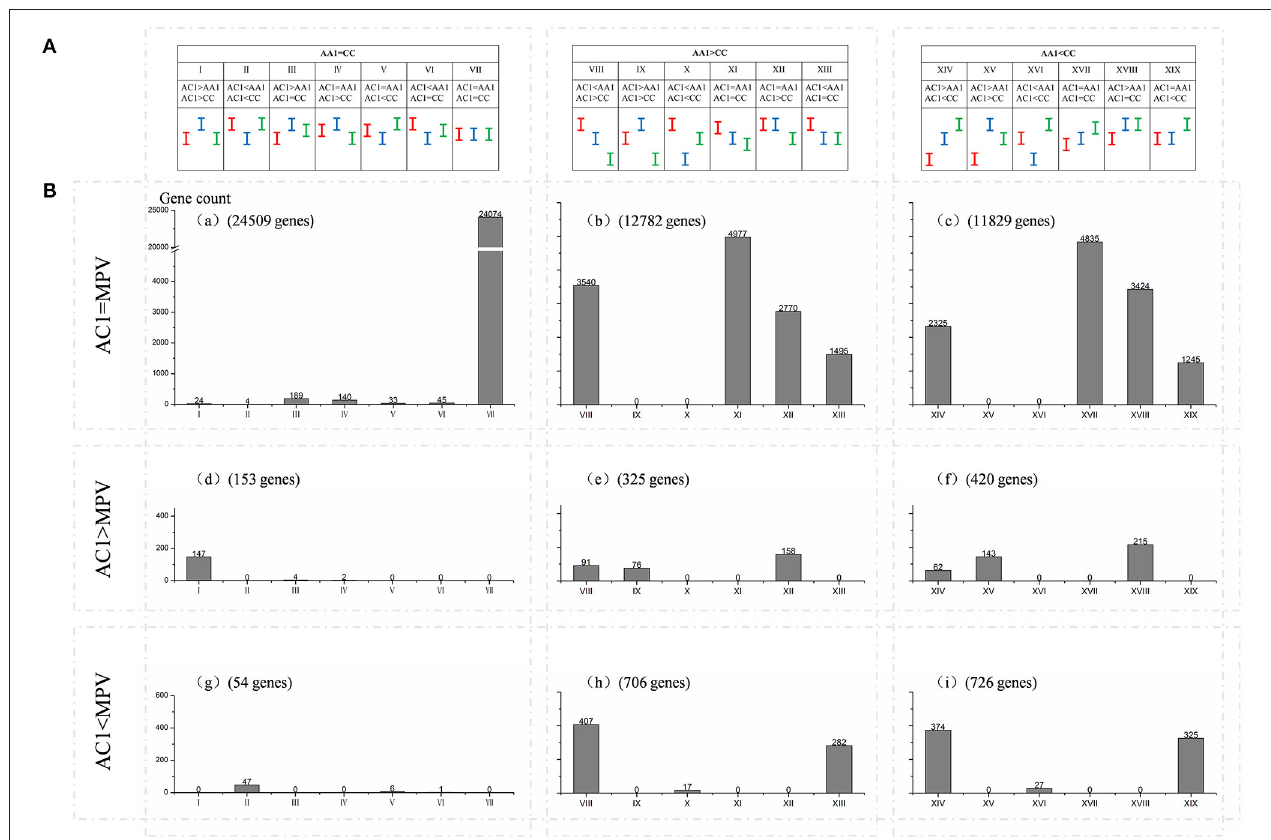
FIGURE 3 | Global classification of gene expression among hybrid AC1 and its progenitors. Genes based on differentially or non-differentially among the hybrid, diploid progenitors, and MPV, were further classified into (A) 19 possible expression patterns (I—XIX; AA1 vs. CC, AA1 vs. AC1, AC1 vs. CC) and (B) 9 major expression categories (a–i; AC1 vs. MPV, AA1 vs. CC). Red, green and blue bars represent the confidence intervals of expression level observed in A and C genome progenitors and hybrid, respectively. Genes are differentially expressed between two samples when their confidence intervals (bars) do not overlap whereas it is equal when they do overlap. The x-axis represents the 19 possible expression patterns. The y-axis represents gene count. The number of genes for each expression pattern in each of expression categories is also